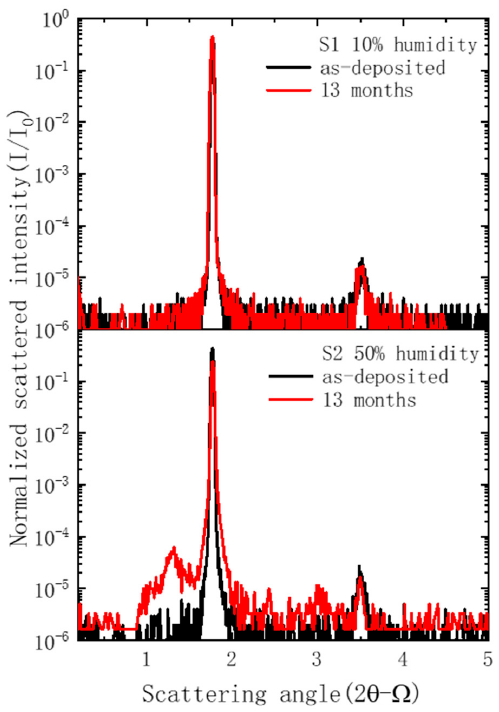
Figure 4. X-ray scattering measurement results of the two Pd/B 4 C multilayers.